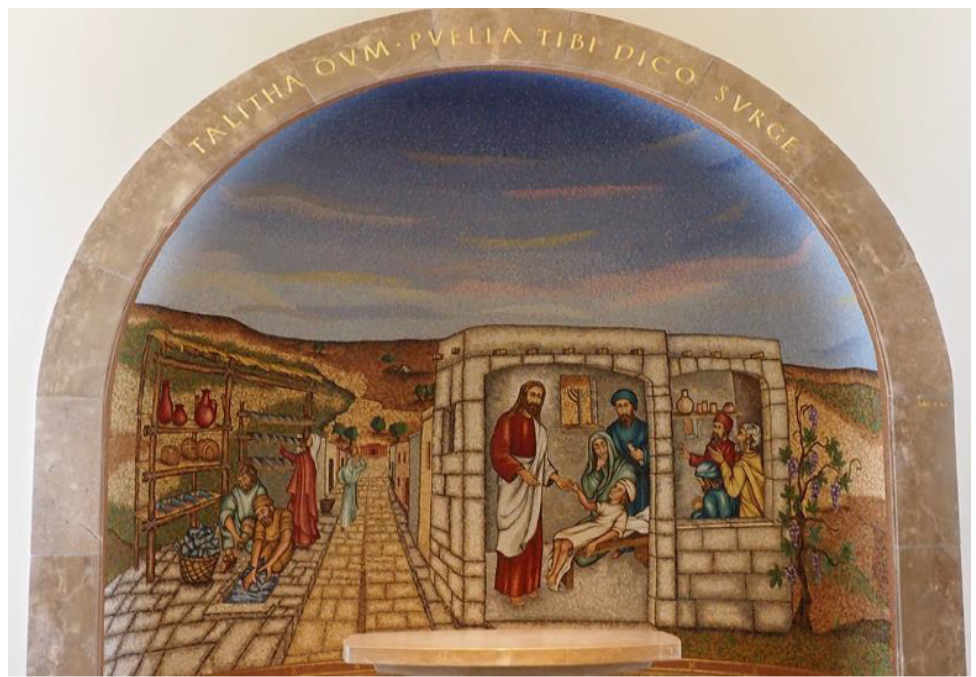
Figure 5. Talitha qum (Daughter of Jairus) , Northwest Chapel (photo: Assaf Pinkus).